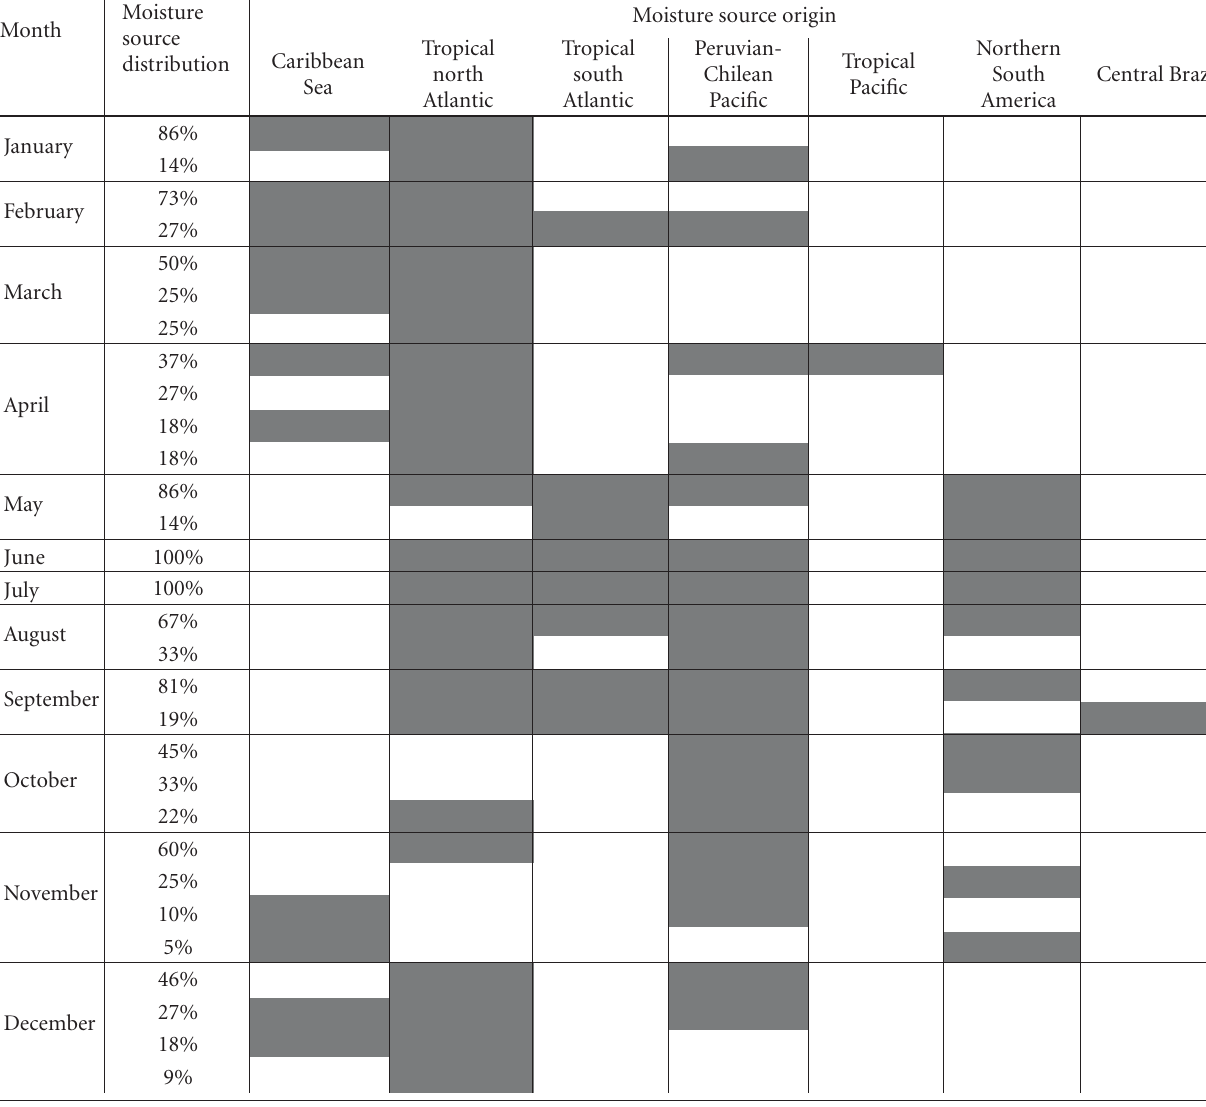
Table 2: Monthly moisture source origin and percentage of distribution considering continental convective system genesis. Moisture source